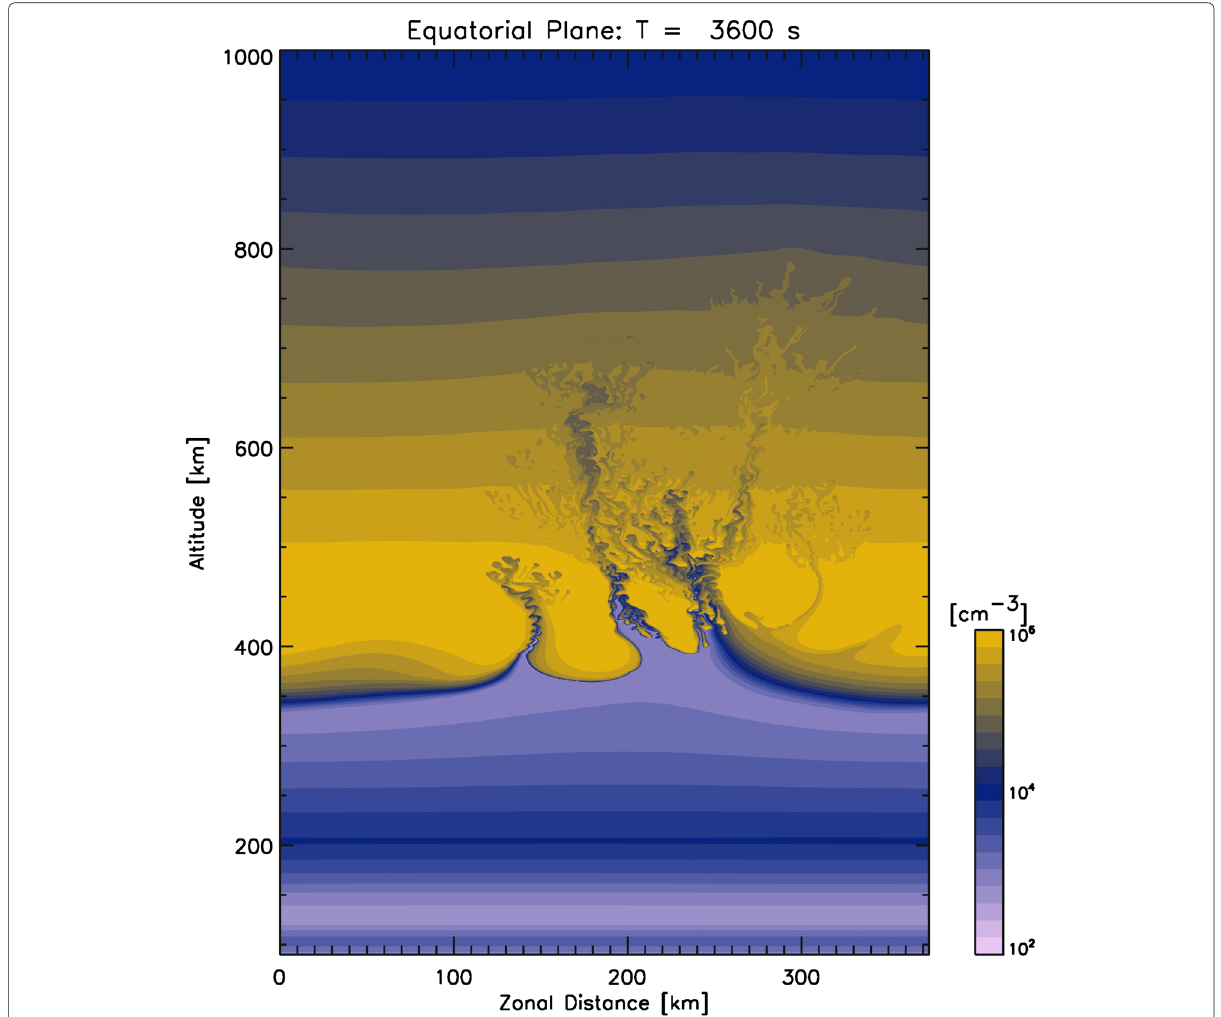
Fig. 9 Higher spatial resolution result obtained using the HIRB model. The initial conditions are the same for Fig.